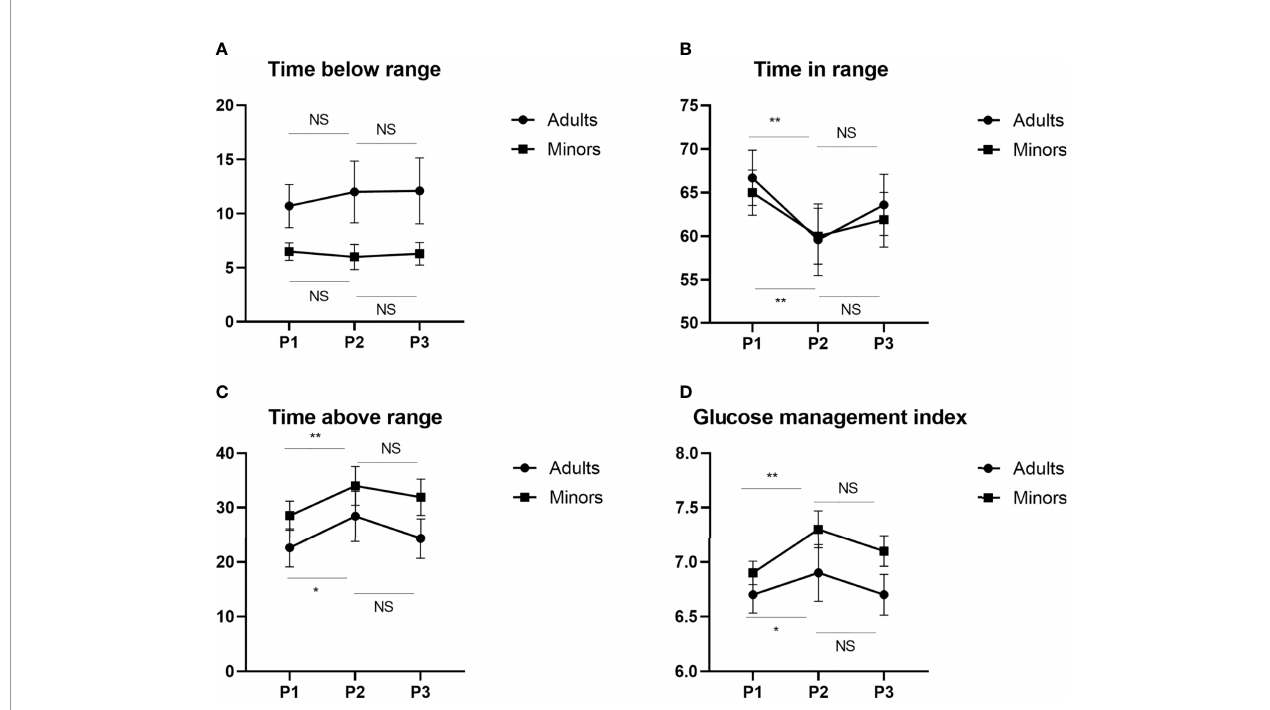
FIGURE 3 | Changes in glycemic indices TBR (A) , TIR (B) , TAR (C) and GMI (D) before, during and after the Chinese New Year public holiday in two age subgroups. GMI, glucose management indicator; TIR, time in range; TAR, time above range; TBR, time below range, P1, the period before the Chinese New Year public holiday; P2, the period during the Chinese New Year public holiday; P3, the period after the Chinese New Year public holiday. NS, not signi fi cant; *P < 0.05; **P <